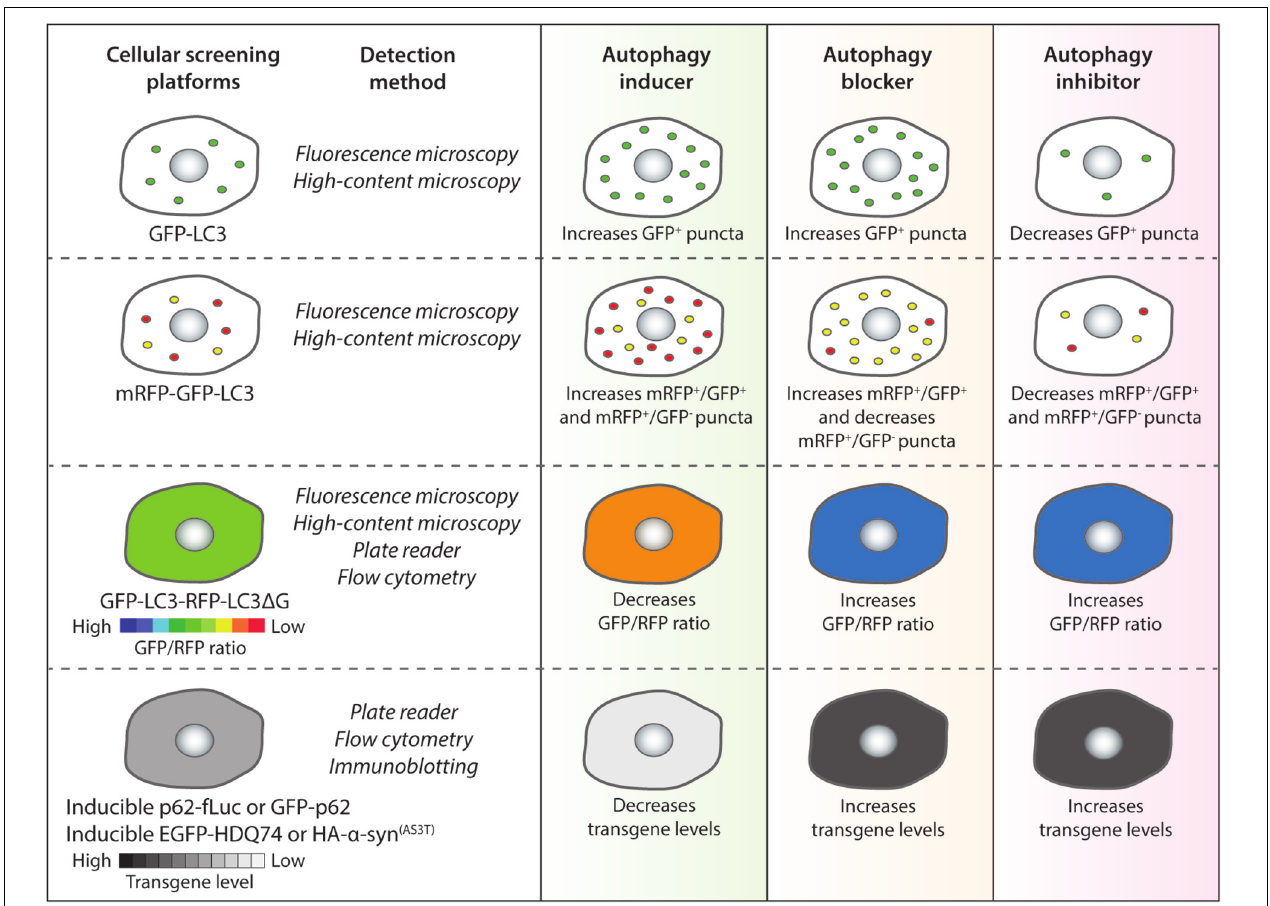
FIGURE 2 | Autophagy chemical screening strategies in mammalian cells. Chemical screening methods that are commonly used for identifying autophagy modulators are based on autophagy reporters (LC3) or autophagy substrates (p62 or aggregation-prone proteins). The detection methods for the respective assays and the expected readouts for autophagy inducers, blockers or inhibitors are indicated as a general guidance.